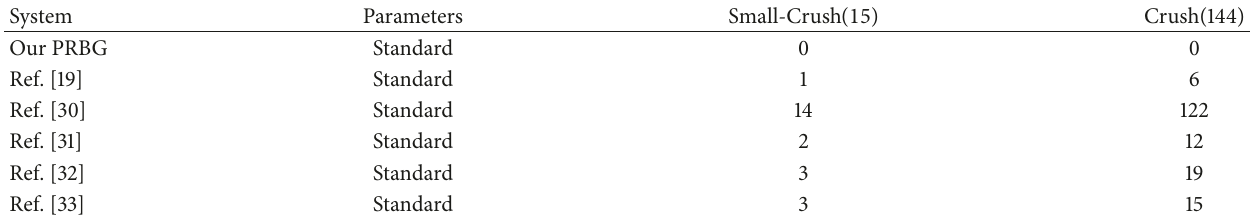
Table 3: TestU01 test results – Failure counts.